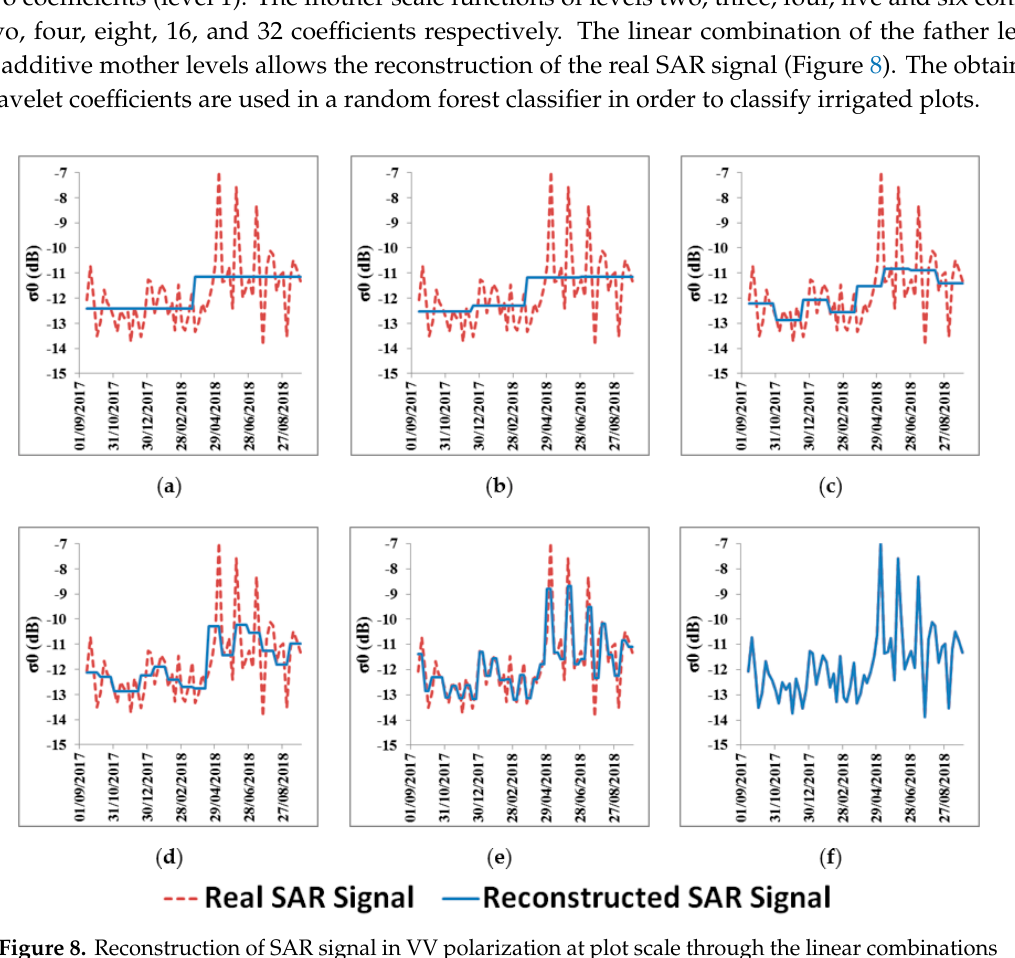
Figure 8. Reconstruction of SAR signal in VV polarization at plot scale through the linear combinations of the ‘Haar’ wavelet coefficients using ( a ) 2 coefficients, ( b ) 4 coefficients, ( c ) 8 coefficients, ( d ) 16 coefficients, ( e ) 32 coefficients, and ( f ) 64 coefficients.